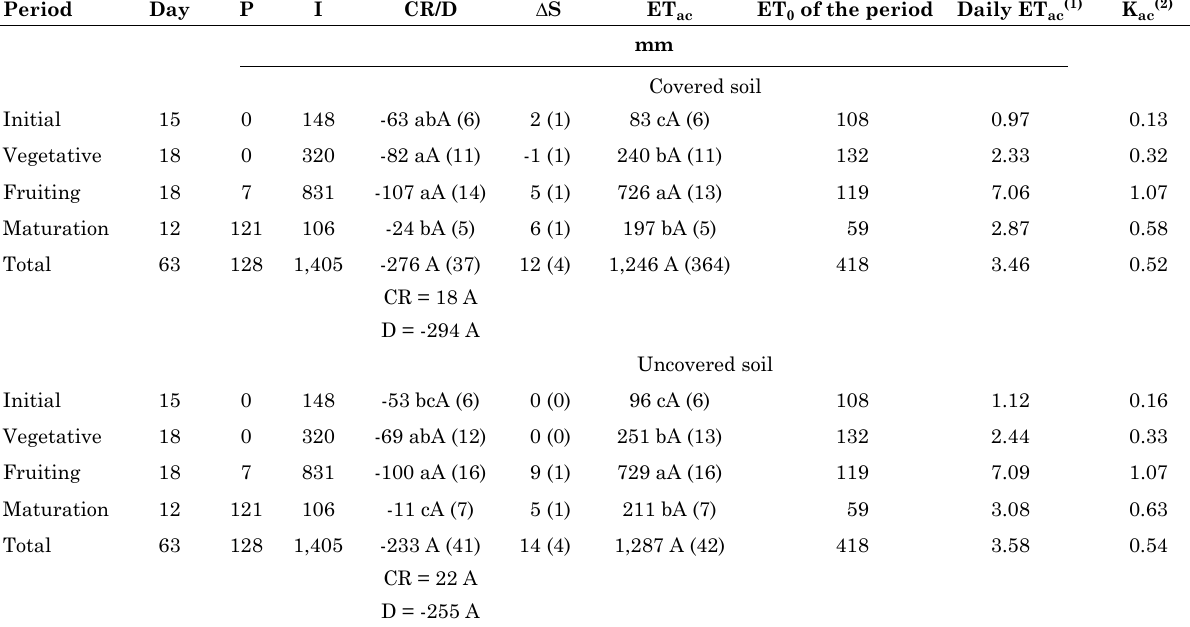
table 2. rainfall (p), irrigation (i), capillary rise (cr), internal drainage (d), variation of soil water storage (∆S), actual (ET ac ) and reference (et 0 ) crop evapotranspiration, and actual crop coefficient (K ac ) for muskmelon, in covered and uncovered soil